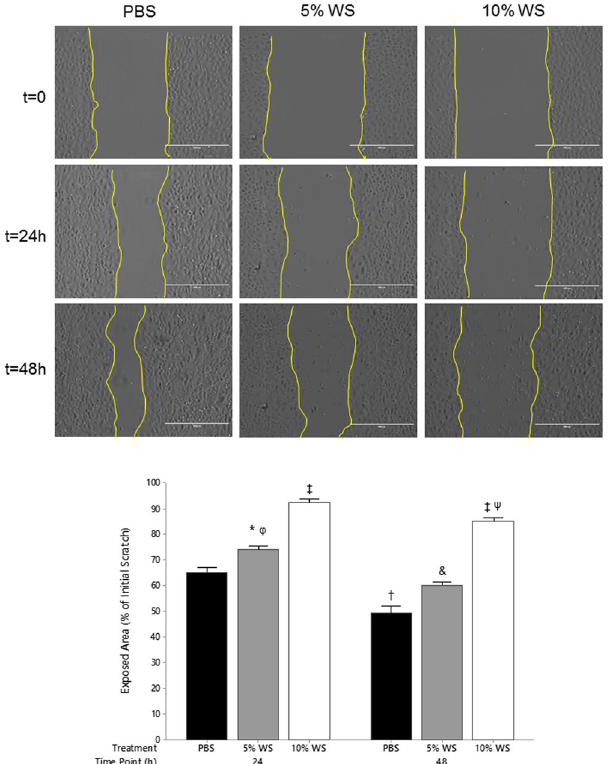
Figure 5. Impaired Migration following Wood Smoke Exposure. A549 cells were grown to confluent monolayers, scratched, and exposed to 5% and 10% WS for up to 48 hours. * P < 0 . 05 vs. 24 h 5% WS; † P < 0 . 001 vs. 24 h PBS; ‡ P < 0 . 001 vs. 24 h and 48 h PBS, 24 h 5% WS, 48 h 5% WS; & P < 0 . 01 vs. 24 h 5% WS, 48 h PBS; ϕ P < 0 . 001 vs. 48 h PBS; Ψ P < 0 . 01 vs. 24 h 5% WS; n = 3. Statistical differences were determined using a two-way ANOVA followed by a Tukey’s post-hoc test. Data presented as mean ±